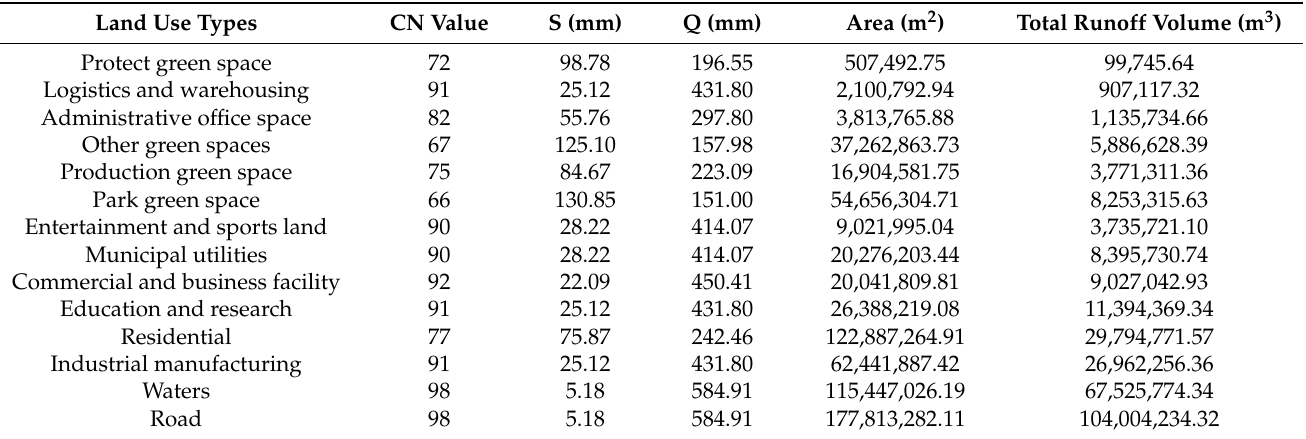
Table 2. Total runoff volume corresponding to each land